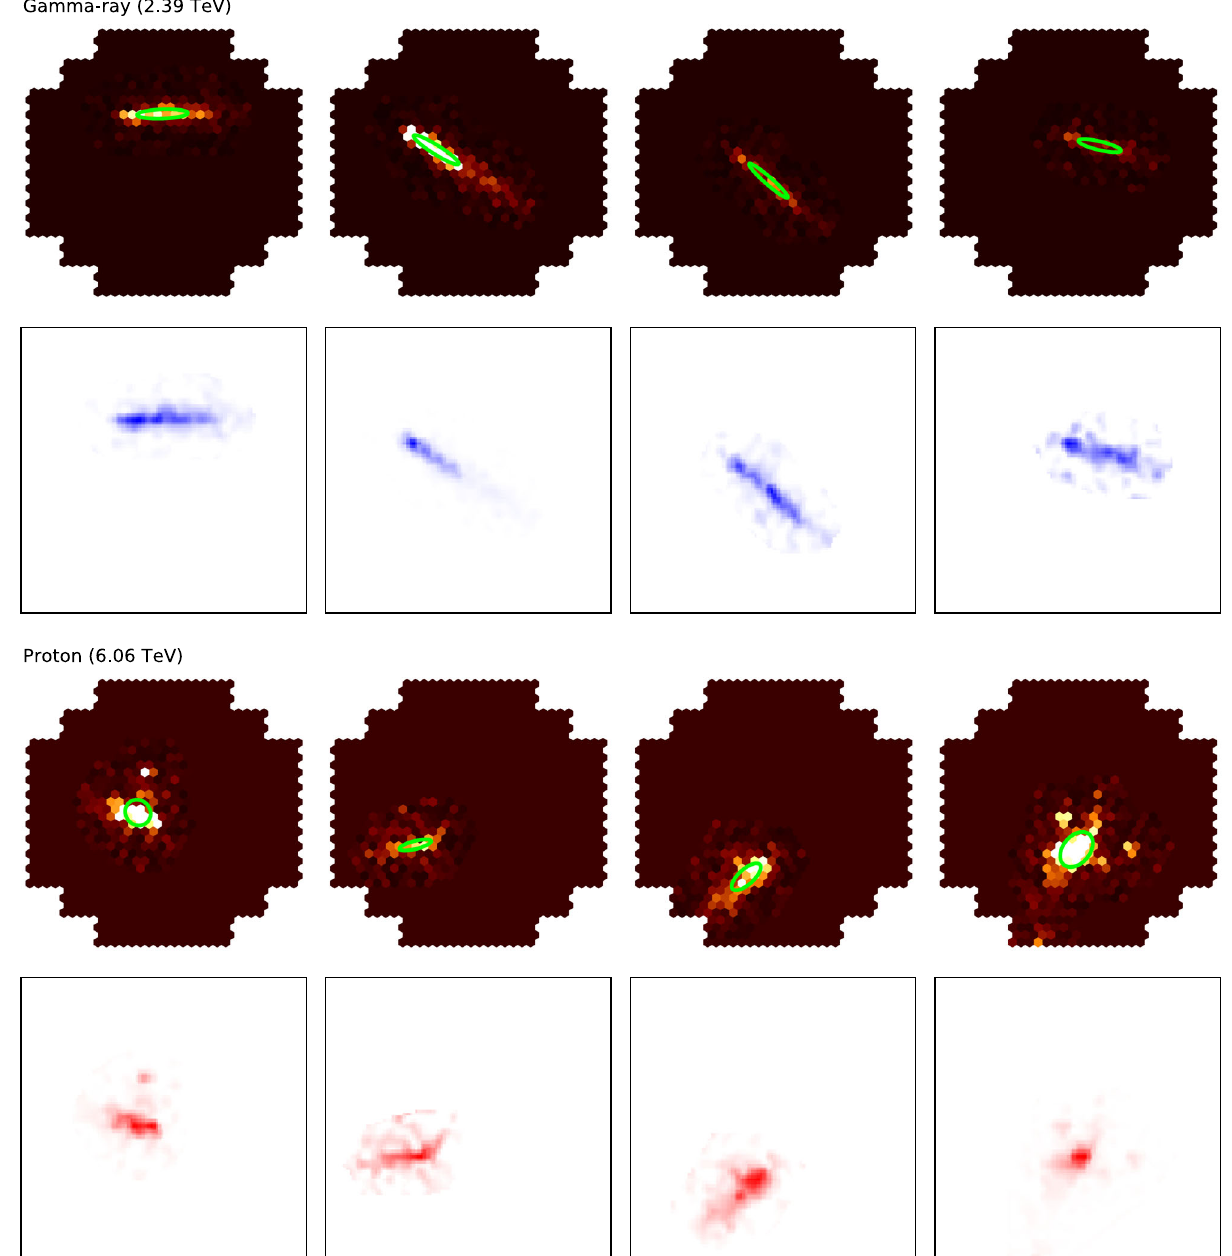
Fig. 3 Example images of gamma-ray and proton events both before (upper panels) and after (lower panels) the image pre-processing step described. Hillas parameter ellipses are overlaid on top of the camera